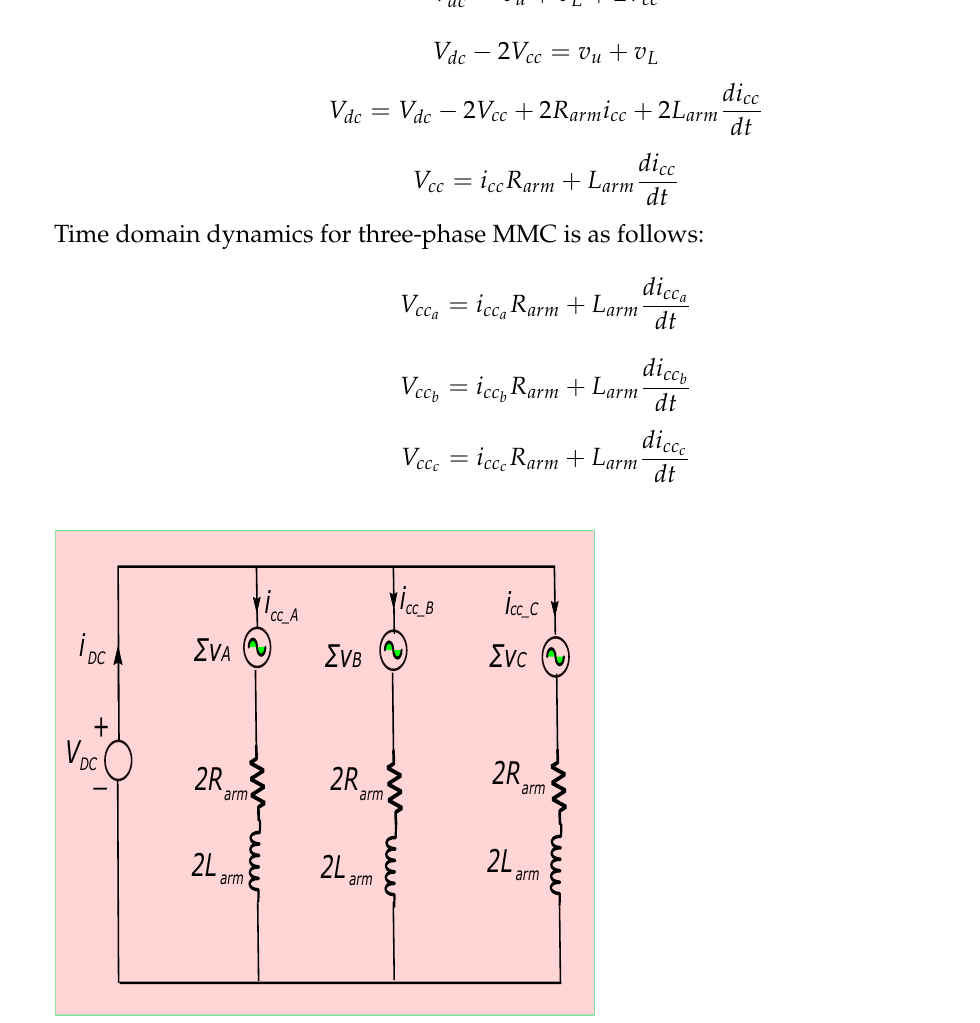
Figure 11. Equivalent circuit of the MMC for circulating